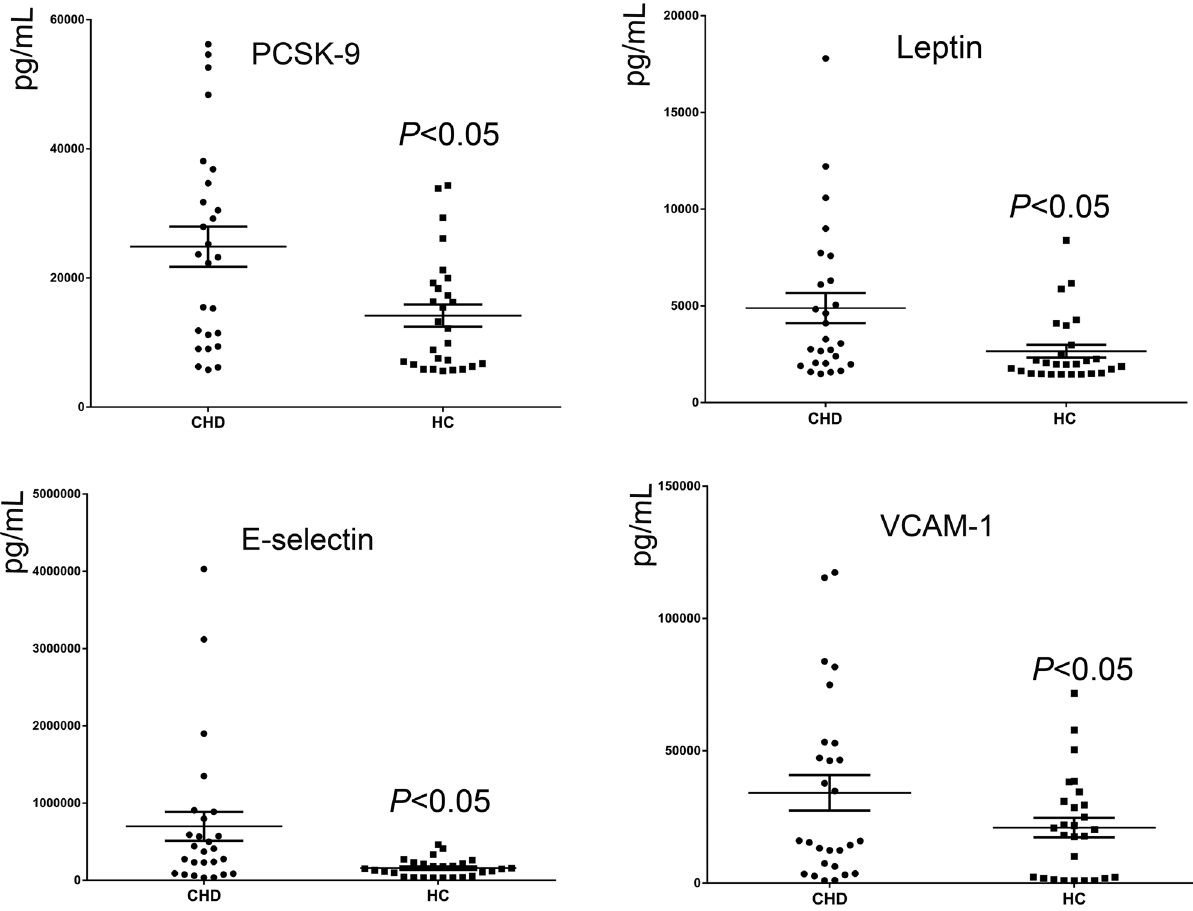
Figure 1: Endothelial cell adhesion factors in patients with CHD was signi fi cantly higher than that in healthy controls: PCSK9 level in CHD and HC subjects; leptin; E - selectin; and VCAM - 1. CHD: coronary heart disease; HC: Healthy